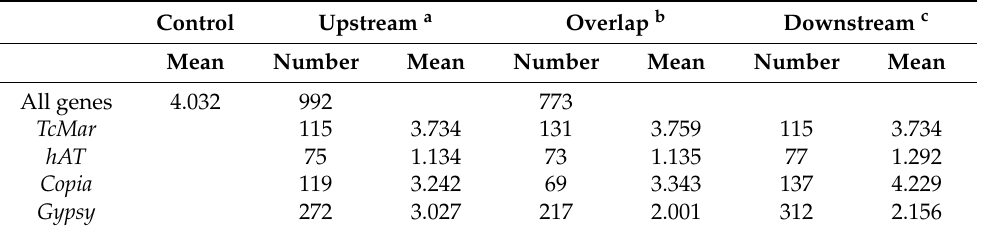
Table 4. Relationship of gene location to TE to gene expression in C. immitis .